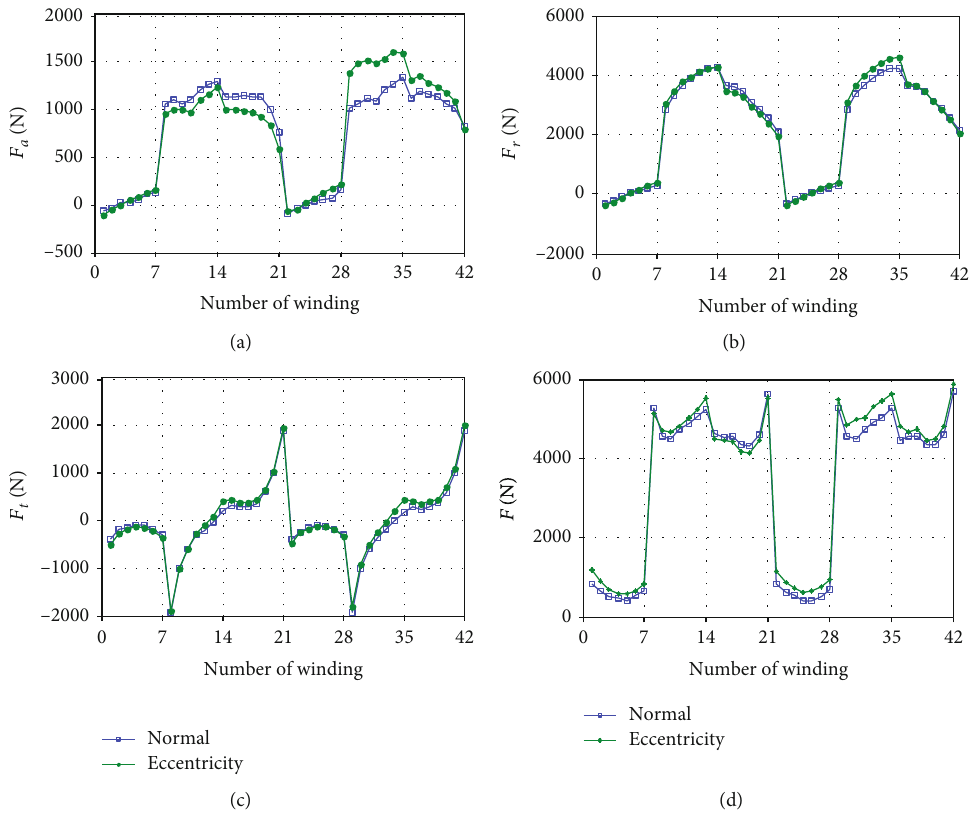
Figure 4: Force on windings: (a) axial force, (b) radial force, (c) tangential force, and (d) resultant force.